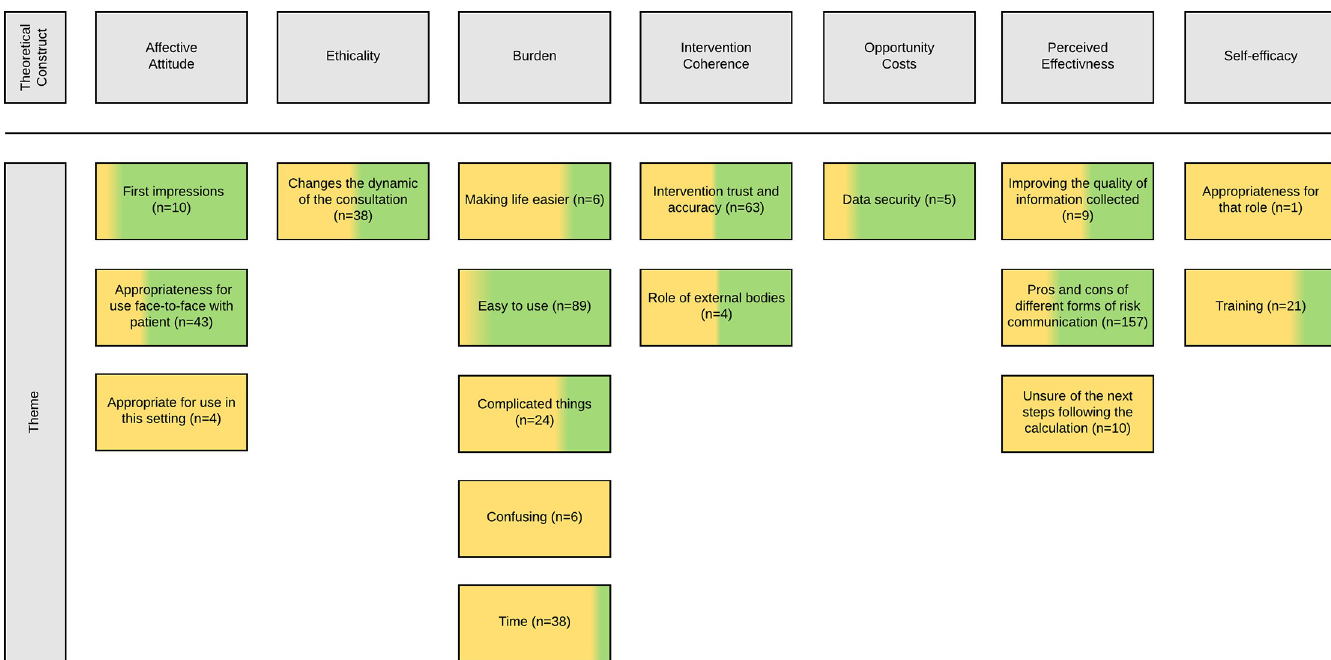
Fig 4. Inductive themes mapped onto Sekhon et al’s Theoretical Framework of Acceptability [12]. The total number of times the theme occurred is presented after each theme name (e.g. n = x). The yellow (primary care) and green (specialist genetics clinic) colouring shows the proportional contribution of each sample to the